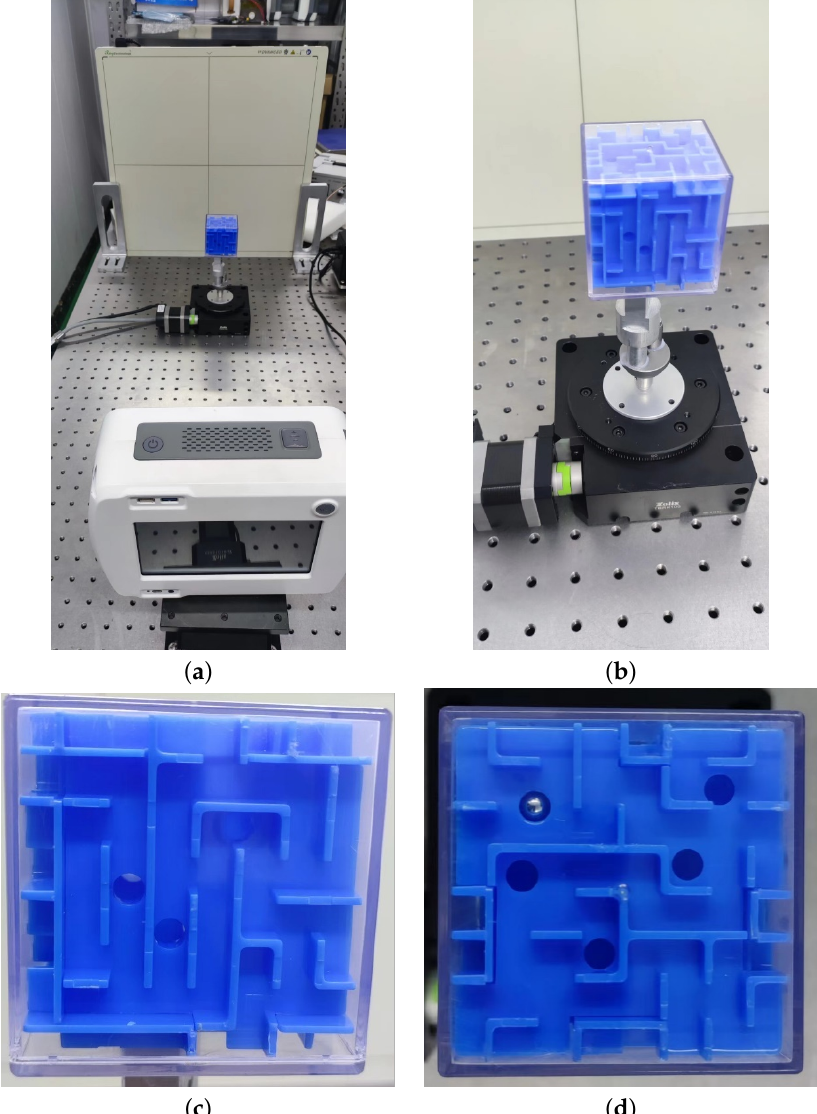
Figure 6. Portable CBCT: ( a ) Experimental equipment; ( b ) Turntable; ( c , d ) Reconstructed